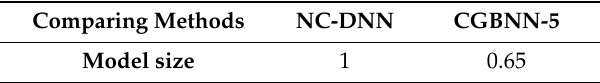
Table 2. Comparison of the normalized model